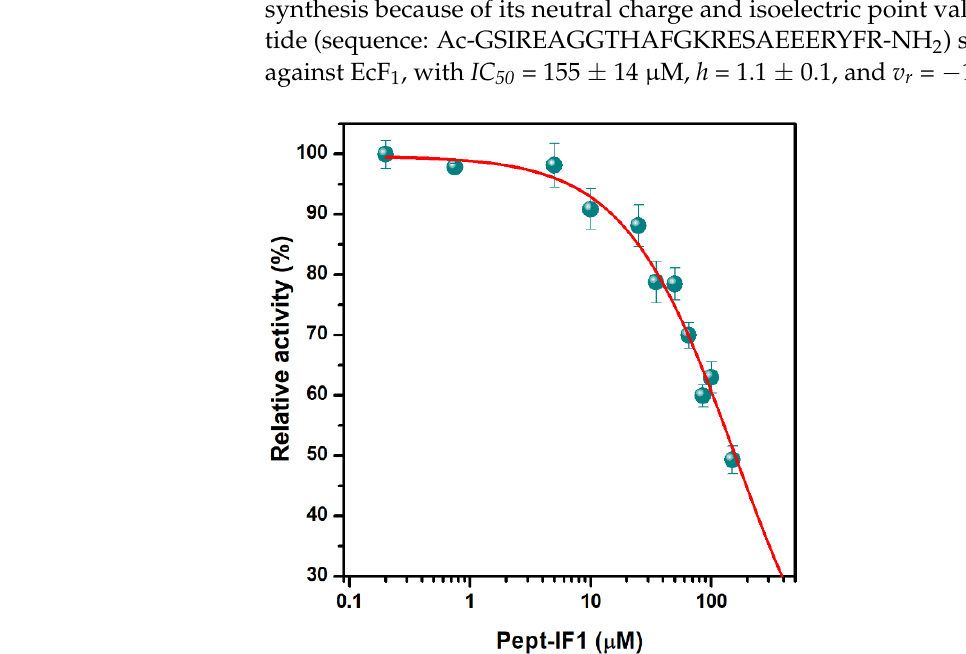
potentially good solubility. From them, the candidate termed as Pept1-IF1 was selected for synthesis because of its neutral charge and isoelectric point value, close to 7.0. This pep- peptide (sequence: Ac-GSIREAGGTHAFGKRESAEEERYFR-NH 2 ) showed inhibitory ac- tide (sequence: Ac-GSIREAGGTHAFGKRESAEEERYFR-NH 2 ) showed inhibitory activity